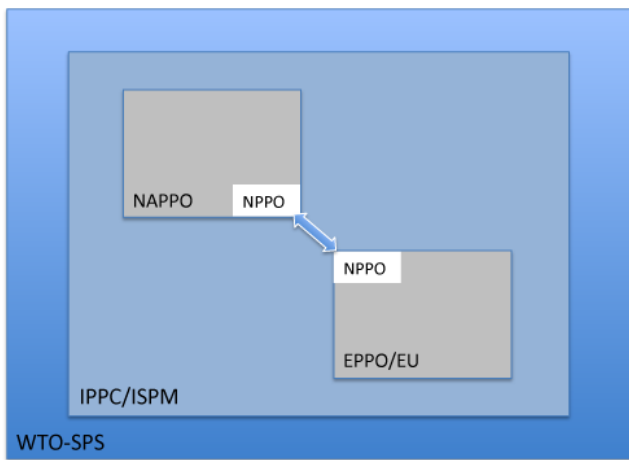
Figure 1. Relationship between phytosanitary organisations as indicated by different coloured boxes; figure adapted from Klapwijk et al., 2016 [52]. Abbreviations. WTO: World Trade